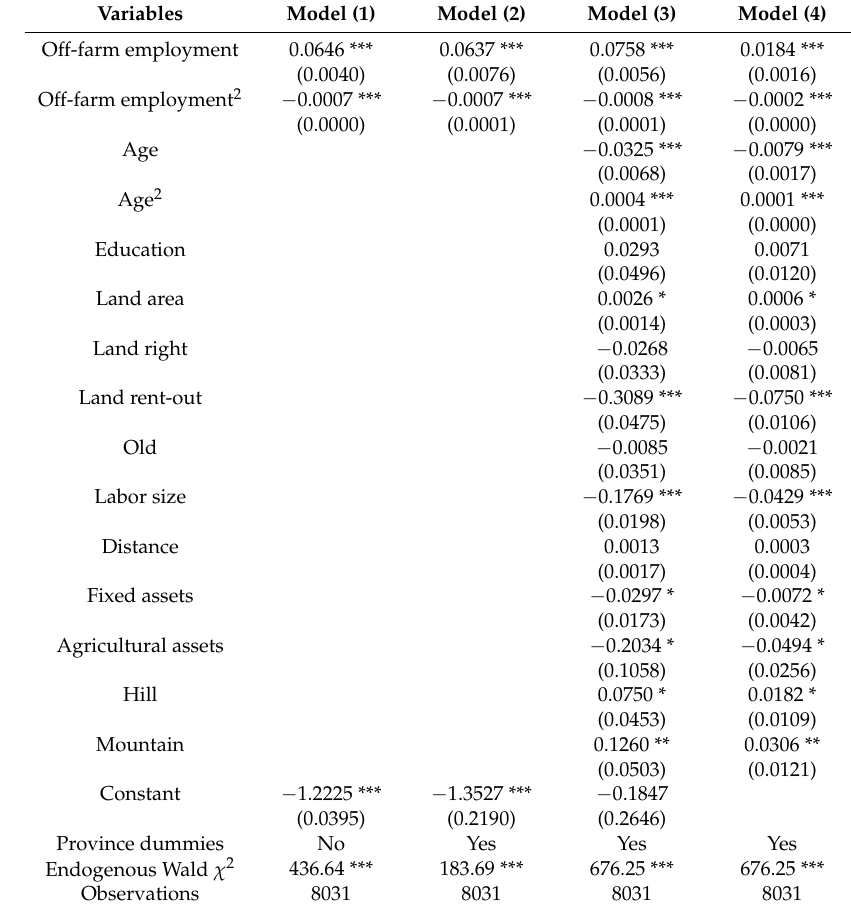
Table 2. The estimated results of IV-Probit model and its marginal effect a